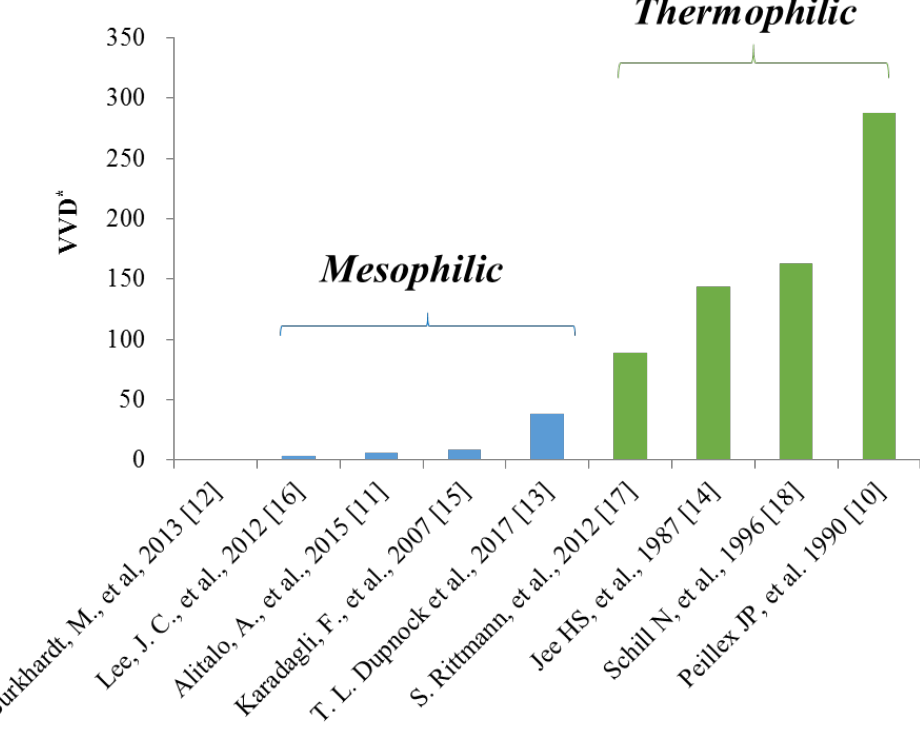
Figure 1. Comparison of the methane production rate between mesophilic and thermophilic hydrogenotrophic methanogens. VVD: Volumetric production of methane per working volume per day [10 – 18].